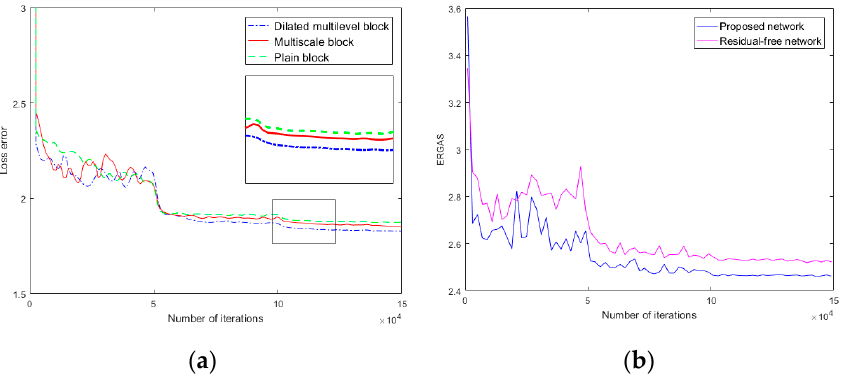
Figure 4. ( a ) Comparison of loss error on the validation dataset. ( b ) Performance-to-epoch curve of the proposed model and corresponding residual-free model.